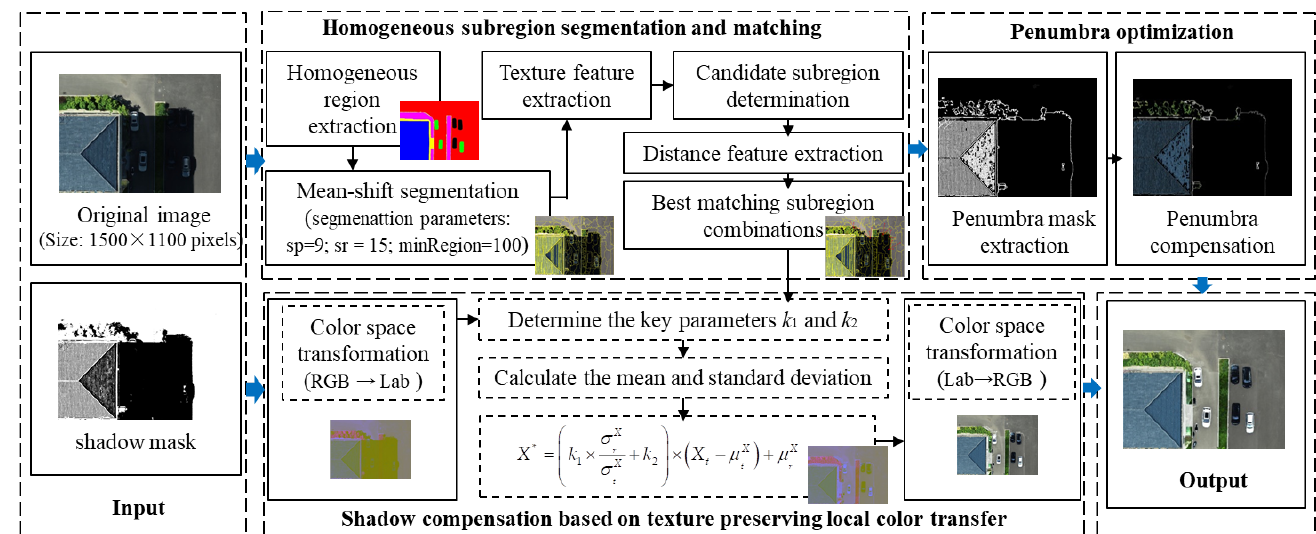
Figure 1. Flowchart of the proposed